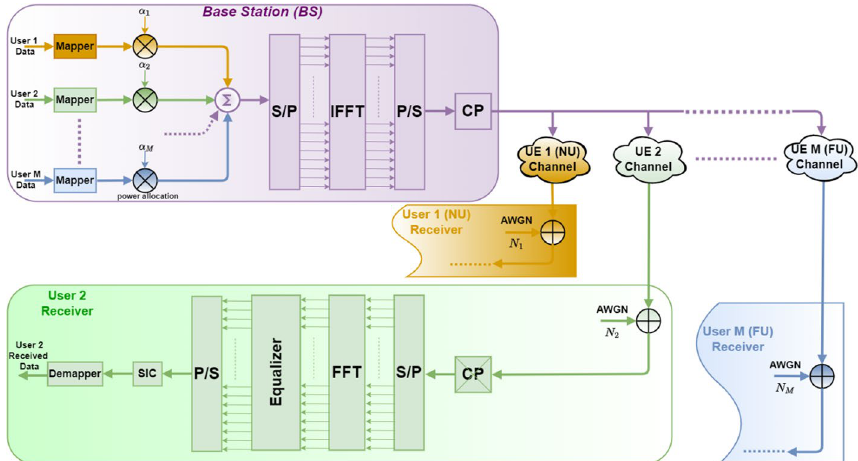
Fig. 1 Block diagram of DL OFDM-NOMA